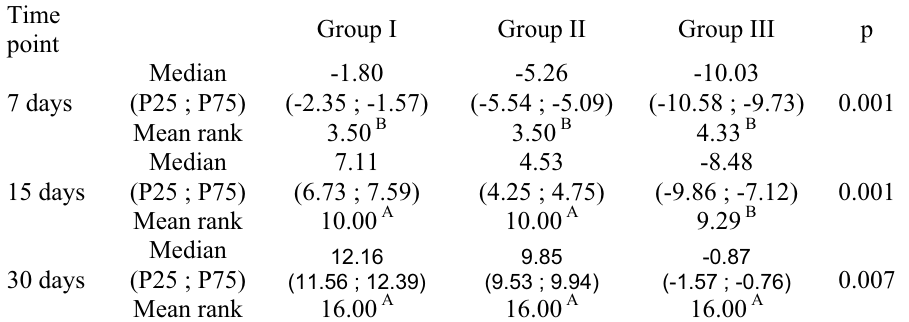
TABLE 3 - Comparison between observation time points (comparison of